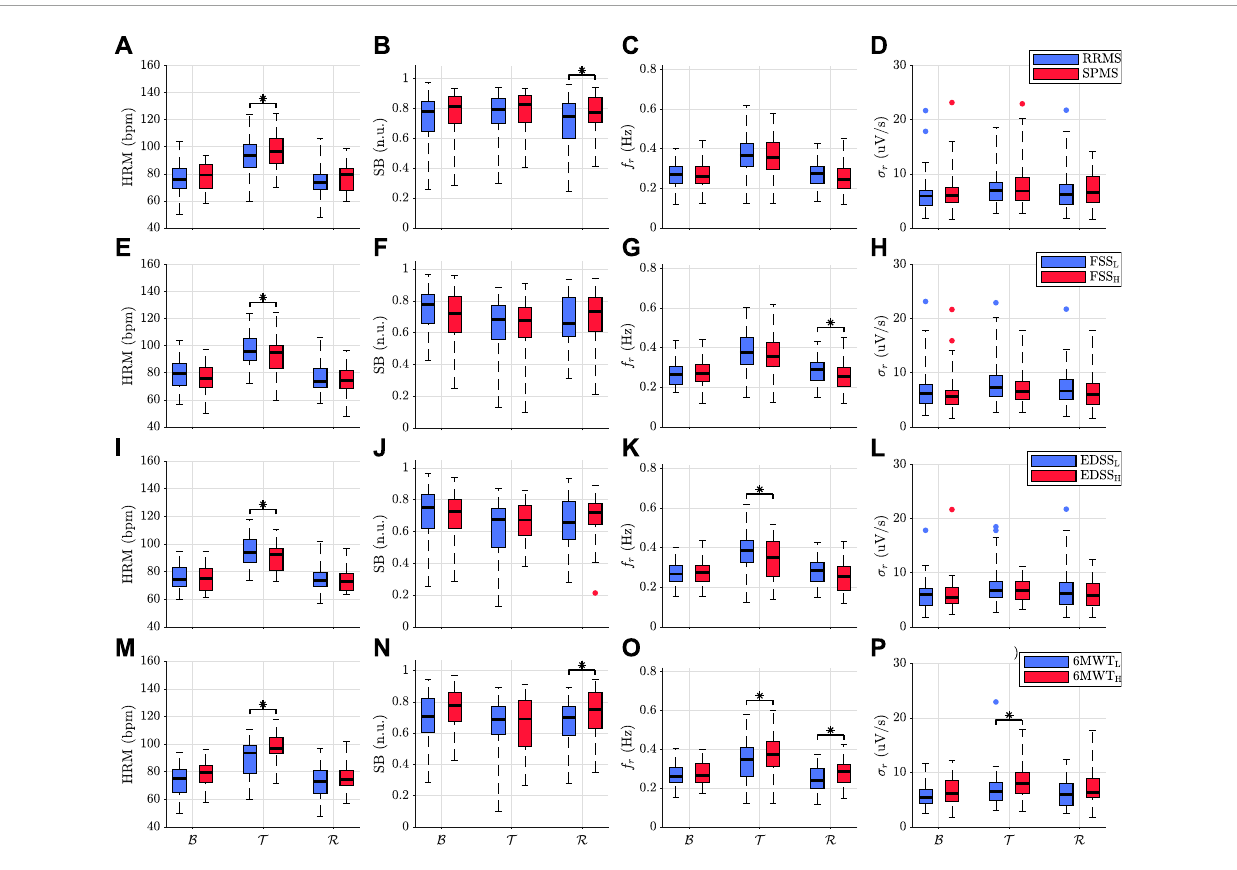
FIGURE 2 Boxplots of HRV and respiratory parameters for different groups of pwMS. Groups based on (A–D) phenotype, (E–H) fatigue severity, (I–L) disability level, and (M–P) walking capacity. Statistically significant group differences are denoted with an asterisk.